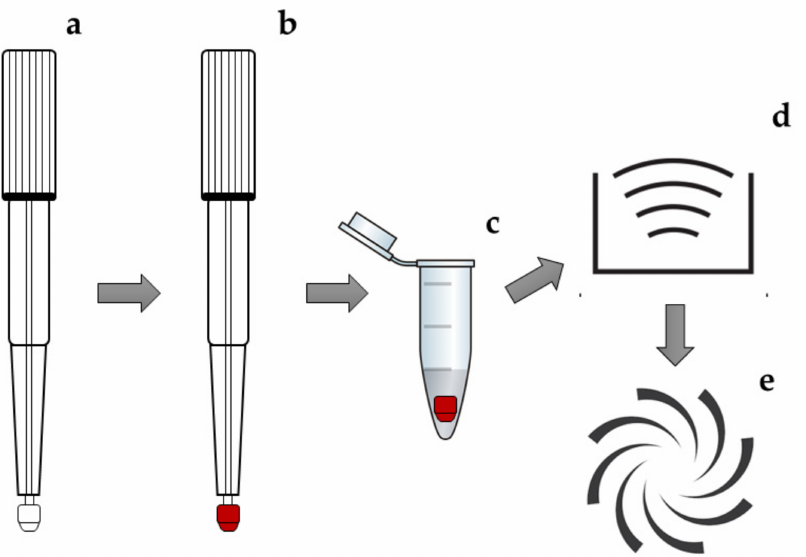
Figure 2. Representation of VAMS workflow: ( a ) Unused VAMS sampler, ( b ) VAMS sampler after accurate collection of 10 µ L whole blood and drying at RT, ( c ) sampled VAMS tips extracted in a proper extraction media under ( d ) UAE and ( e ) VAE.